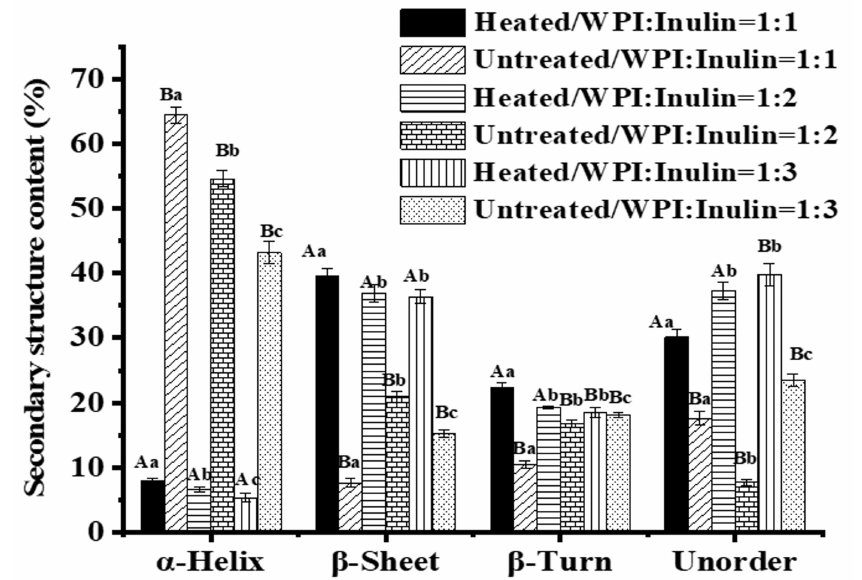
Figure 9. Secondary structures content (%) of whey protein in presence of inulin before and after dry heating. Di ff erent lowercase letters denote significant di ff erence between samples with di ff erent whey protein and inulin ratios for untreated or dry-heated samples; Di ff erent uppercase letters denote significant di ff erence between untreated and dry-heated samples at same whey protein and inulin